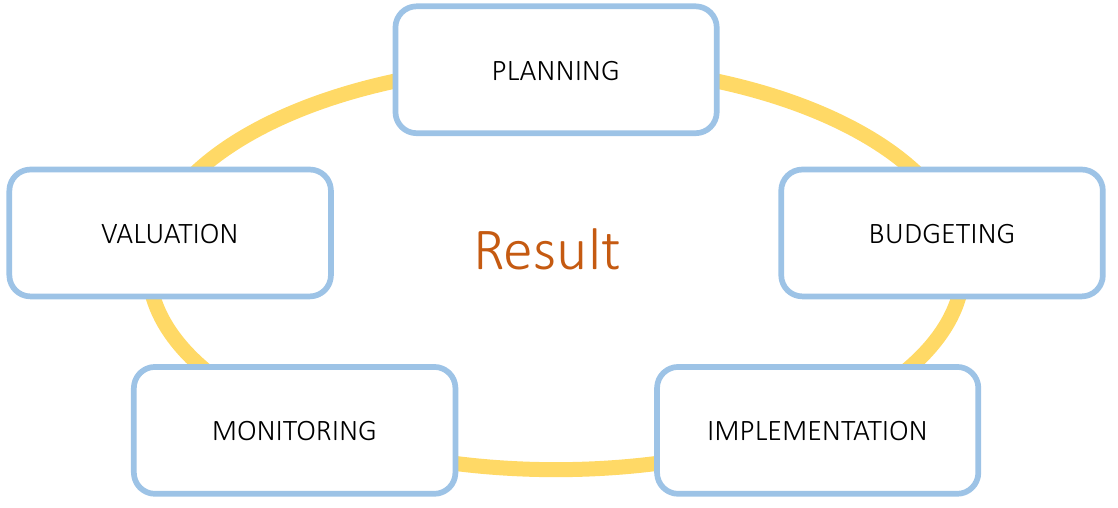
Figure 2. Components of a result-oriented budget process management